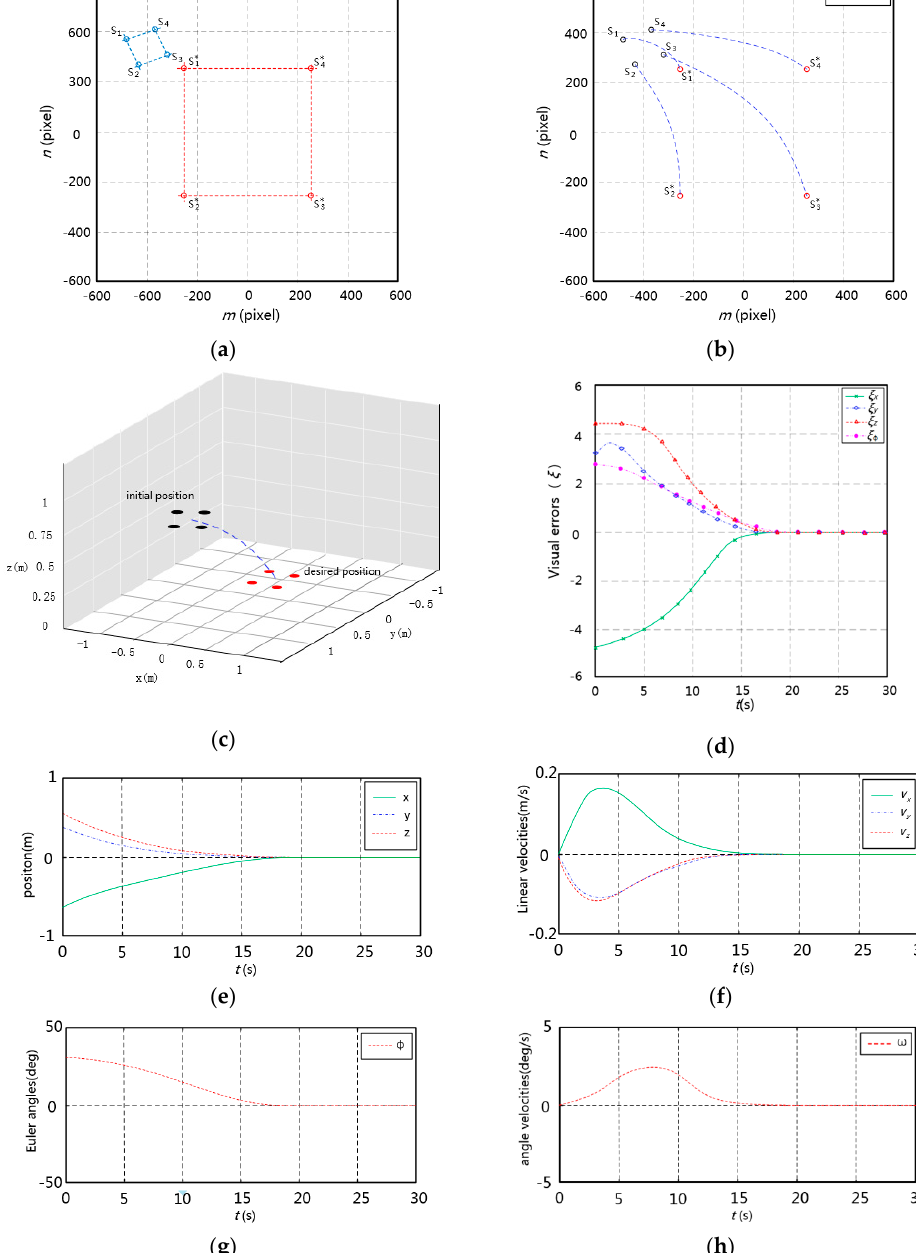
Figure 7. Visual servoing performances of the proposed method.